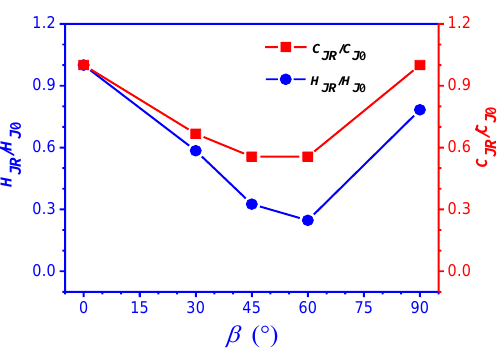
Figure 7. Stress–strain and HPS–strain curves for samples with different crack angles.